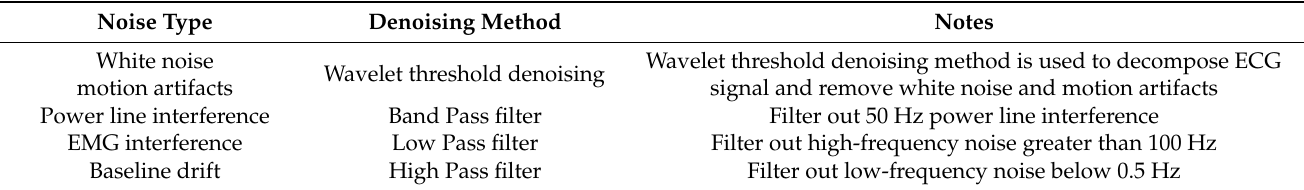
Table 1. ECG signal denoising.